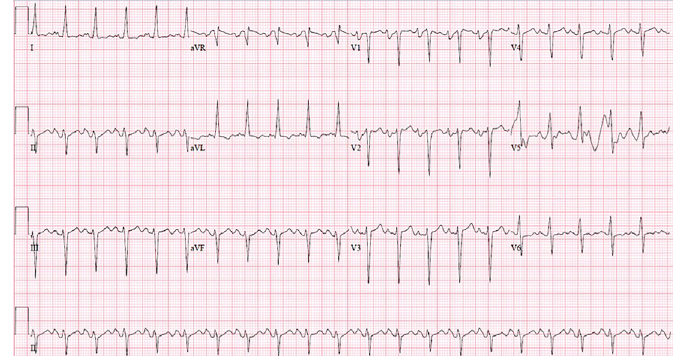
Image 2. Electrocardiogram of a 48-year-old male with respiratory distress and altered mental